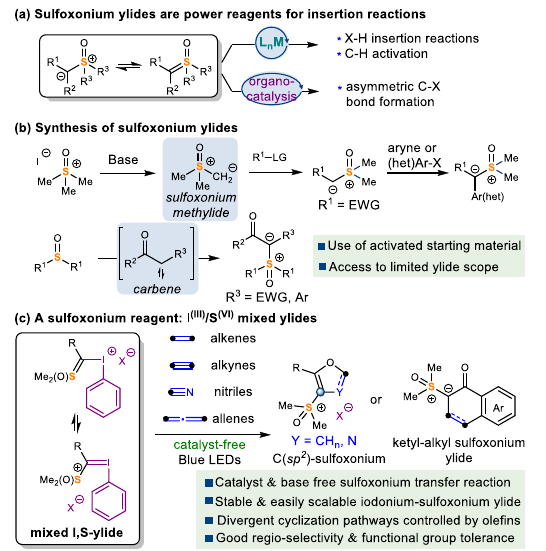
Fig.1|Synthesisandreactivityofsulfoxoniumylides.a Sulfoxoniumreactivities. b Previoussynthesisofsulfoxonium(ylide). c Ourstrategy:I (III) /S (VI) mixedylidesasa sulfoxonium